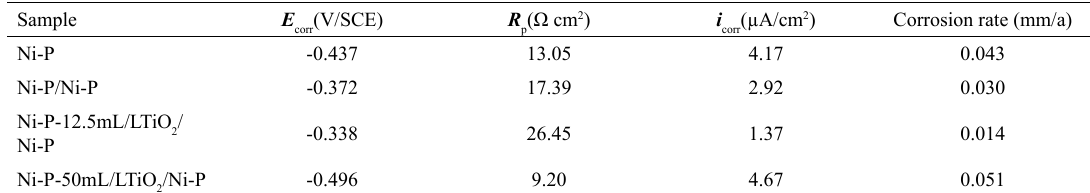
Table 2. Potentiodynamic polarization parameters for Ni-P coating and duplex Ni-P-TiO